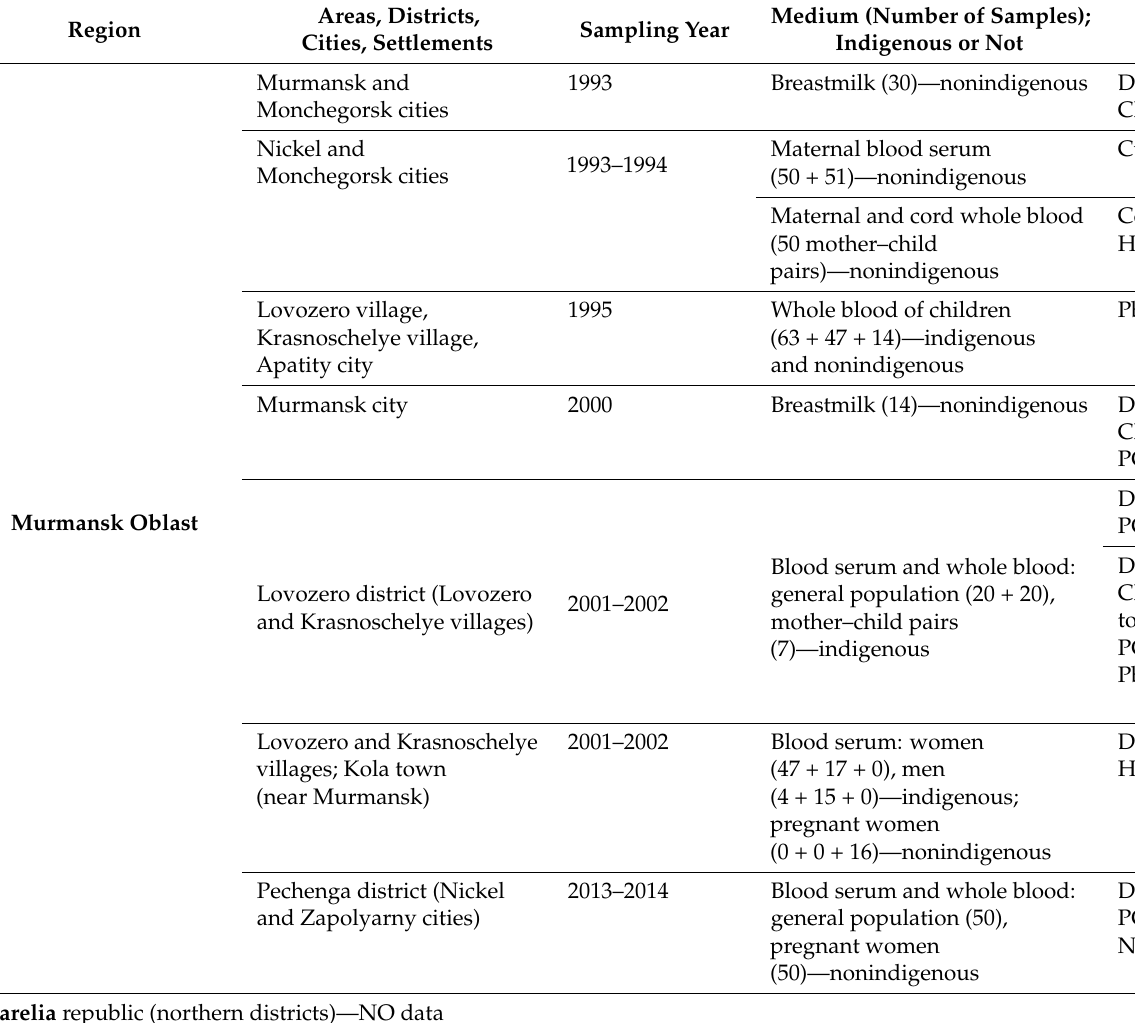
Table 2. Russian Arctic HUMAN biomonitoring of contaminants.